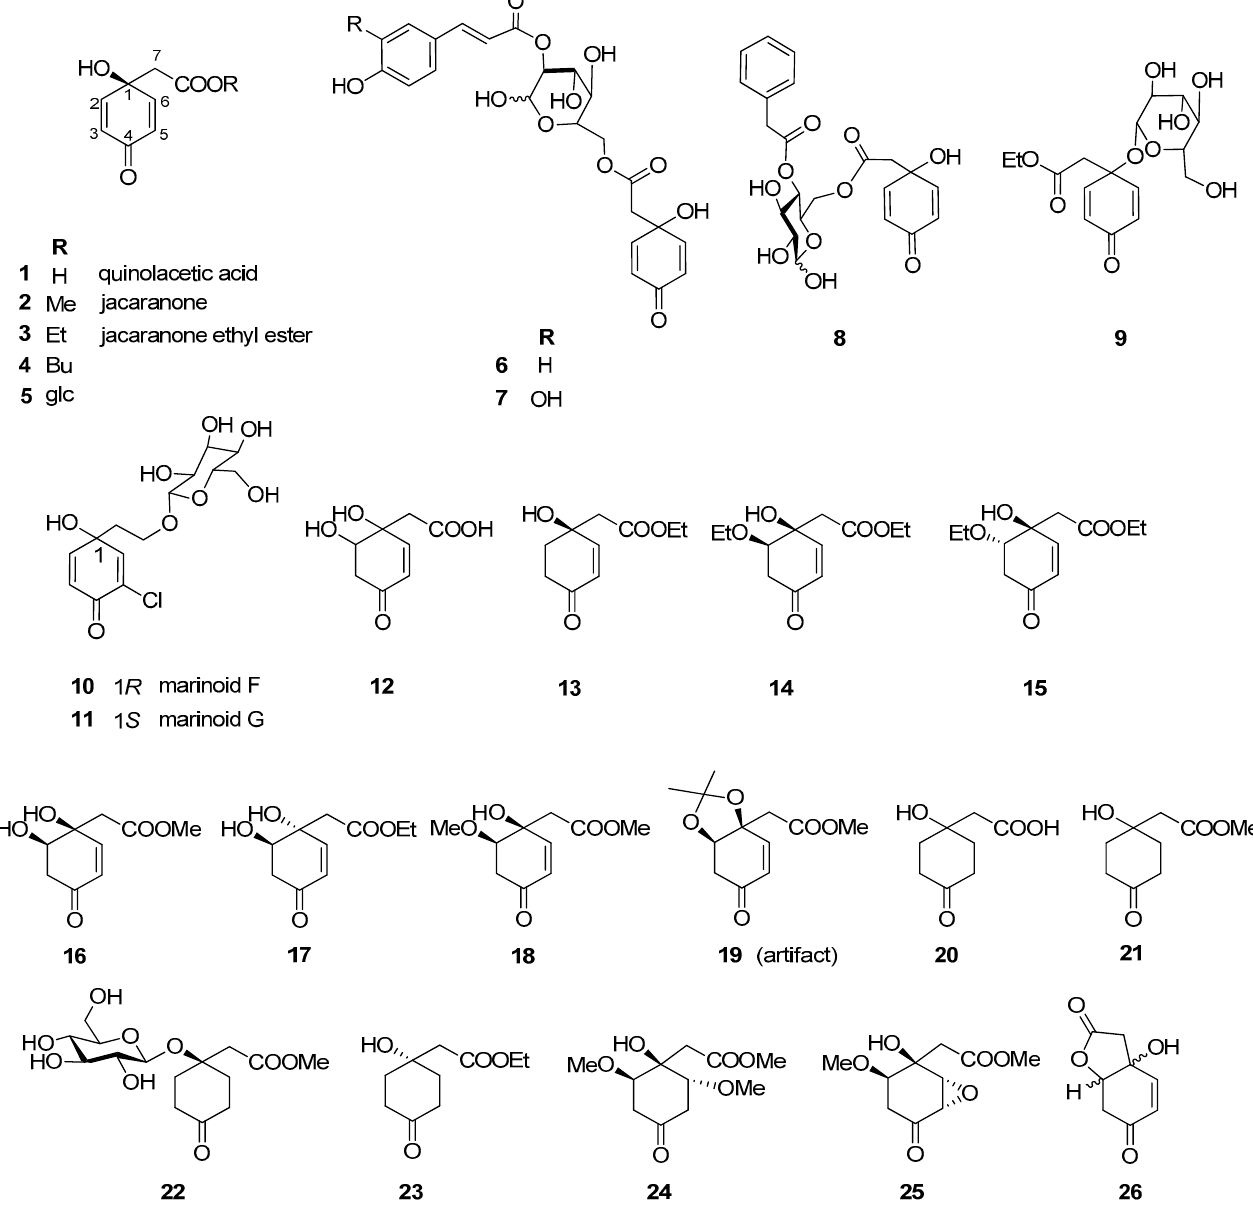
Figure 2. Naturally occurring jacaranone derivatives (monomers) *. * Stereochemistry of the compounds is indicated according to the source literature; Me = methyl, Et = ethyl, Bu = butyl, glc = glucose.